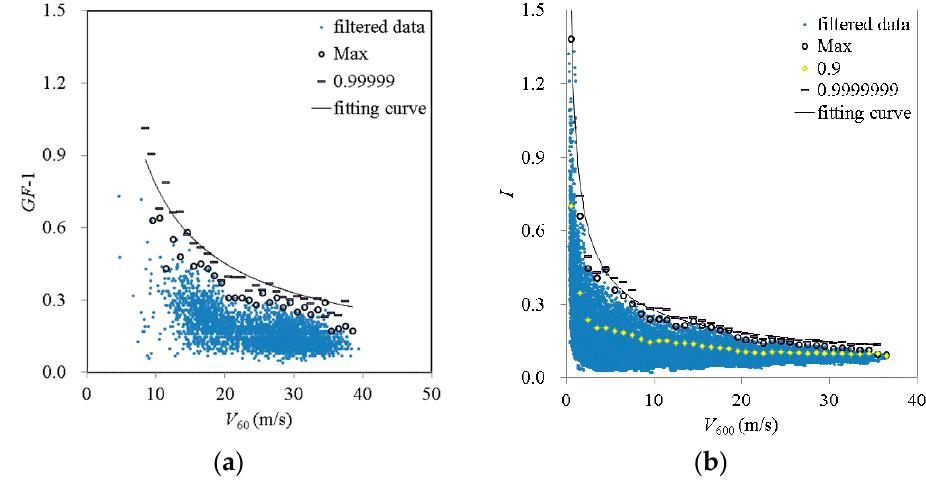
Figure 6. Extreme value analysis during typhoons. ( a ) Gust factor; ( b ) turbulence intensity.